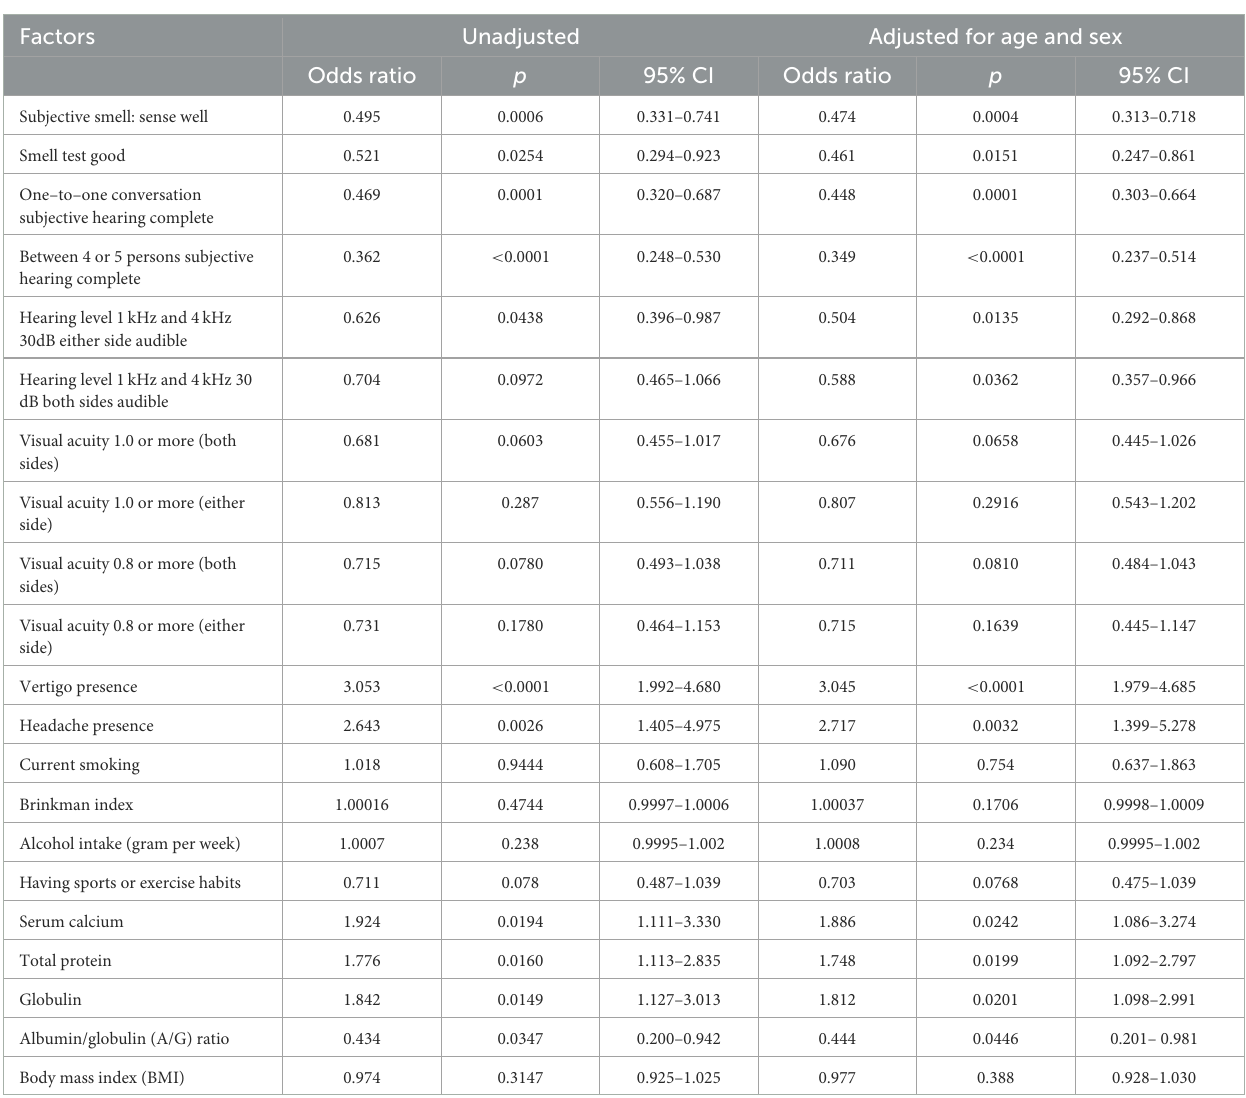
TABLE 4 Influence of various factors on tinnitus presence.